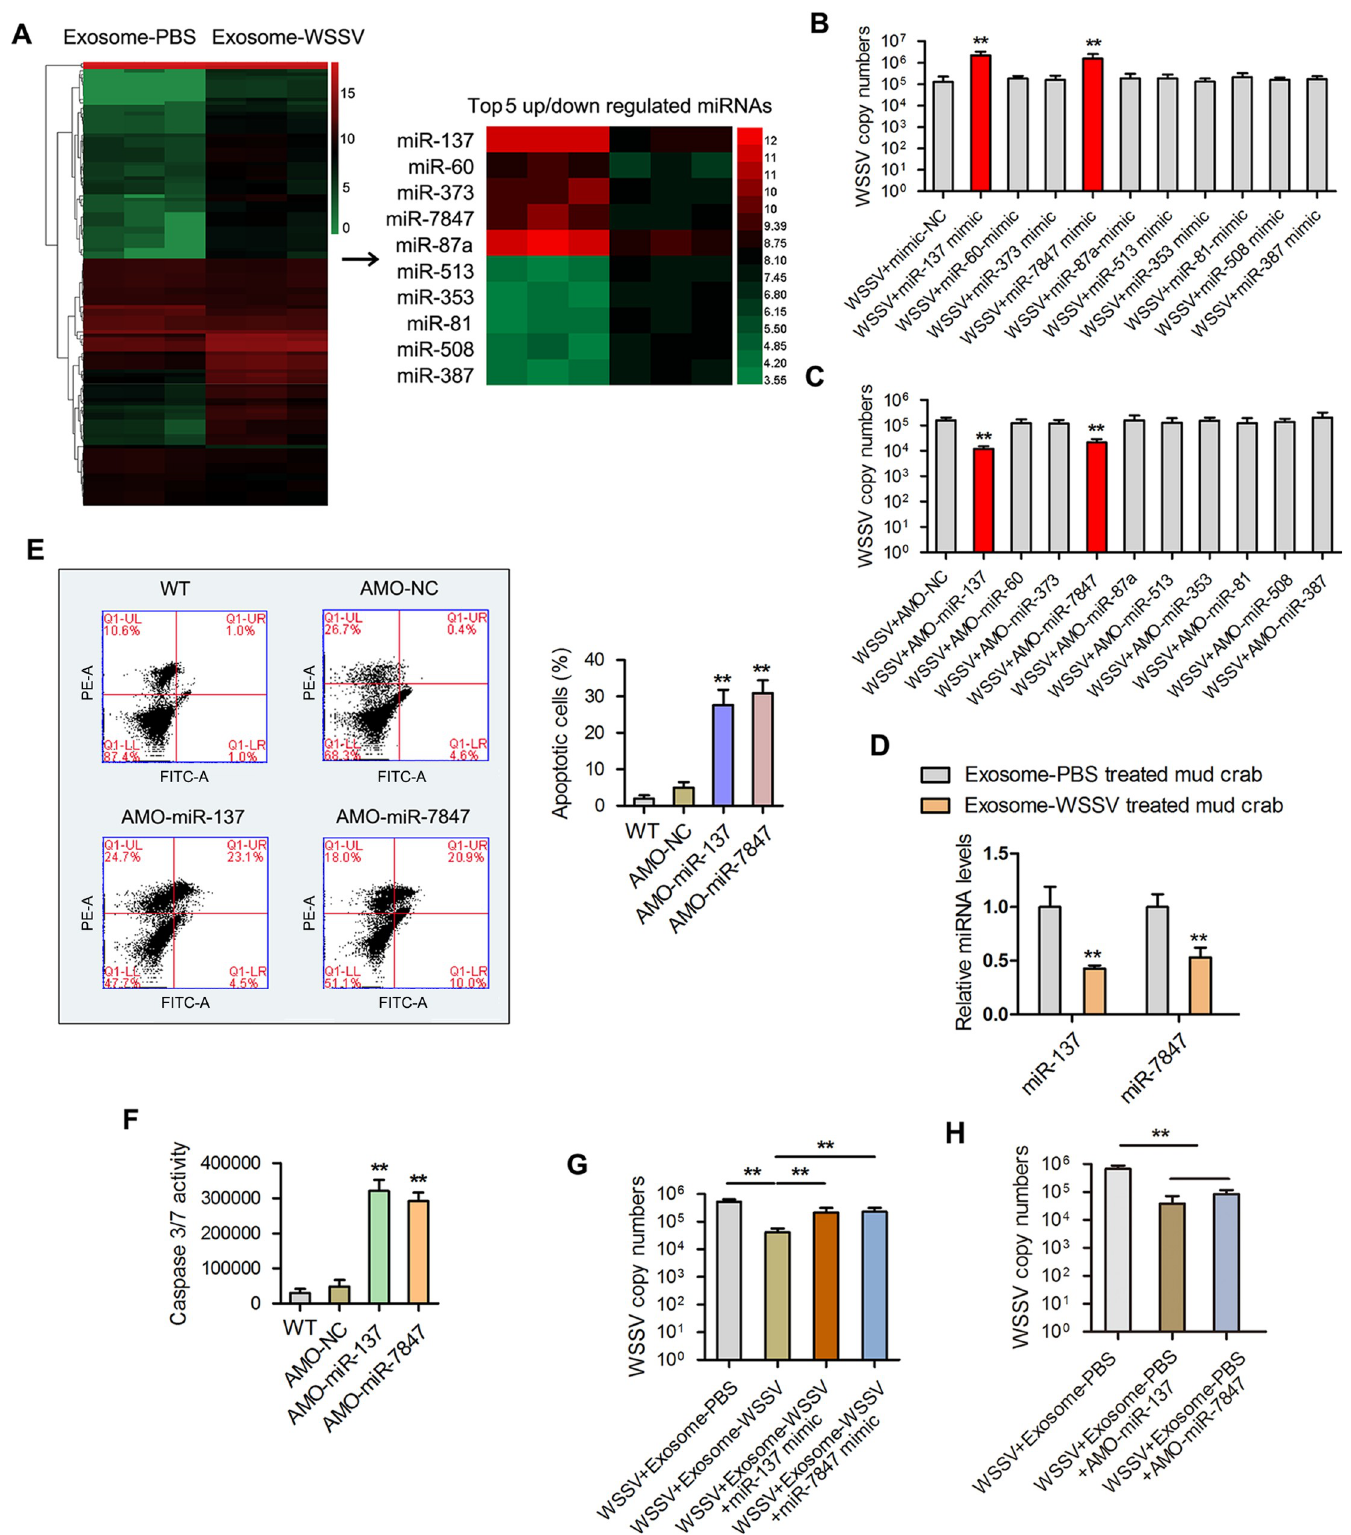
Fig 3. Exosomal miR-137 and miR-7847 were characteristically secreted to mediate apoptosis and virus invasion in mud crab. (A) Microarray analysis of exosomal miRNAs were presented in a heatmap, the top5 up/down regulated miRNAs in the indicated exosomes were listed in detail. (B-C) The effects of the indicated miRNAs